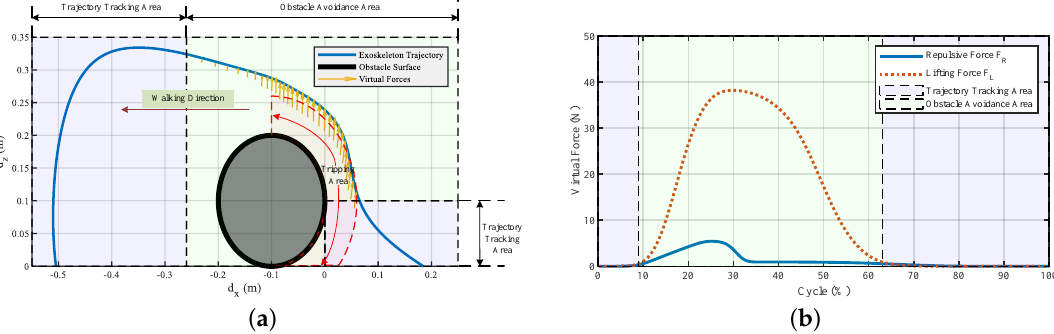
Figure 12. Trajectory and virtual forces of the exoskeleton system during stepping over a ball-like obstacle. ( a ) Trajectory of the exoskeleton. The dotted red area is the dangerous area that might cause scuffing if the swing leg could not be controlled. ( b ) Repulsive and lifting forces generated during stepping over a ball-like obstacle. F R and F L are the forces used to help the pilot avoid kicking the obstacle and lift the swing leg,